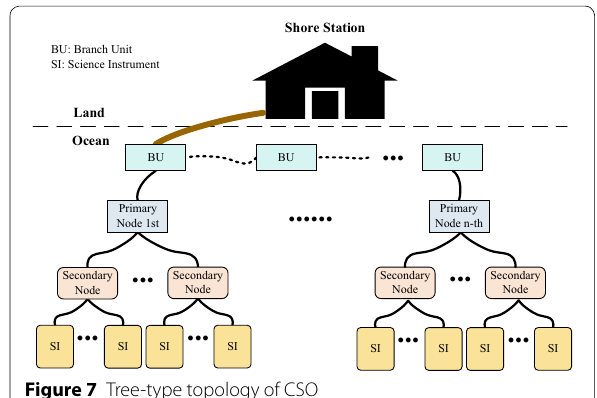
Figure 7 Tree-type topology of